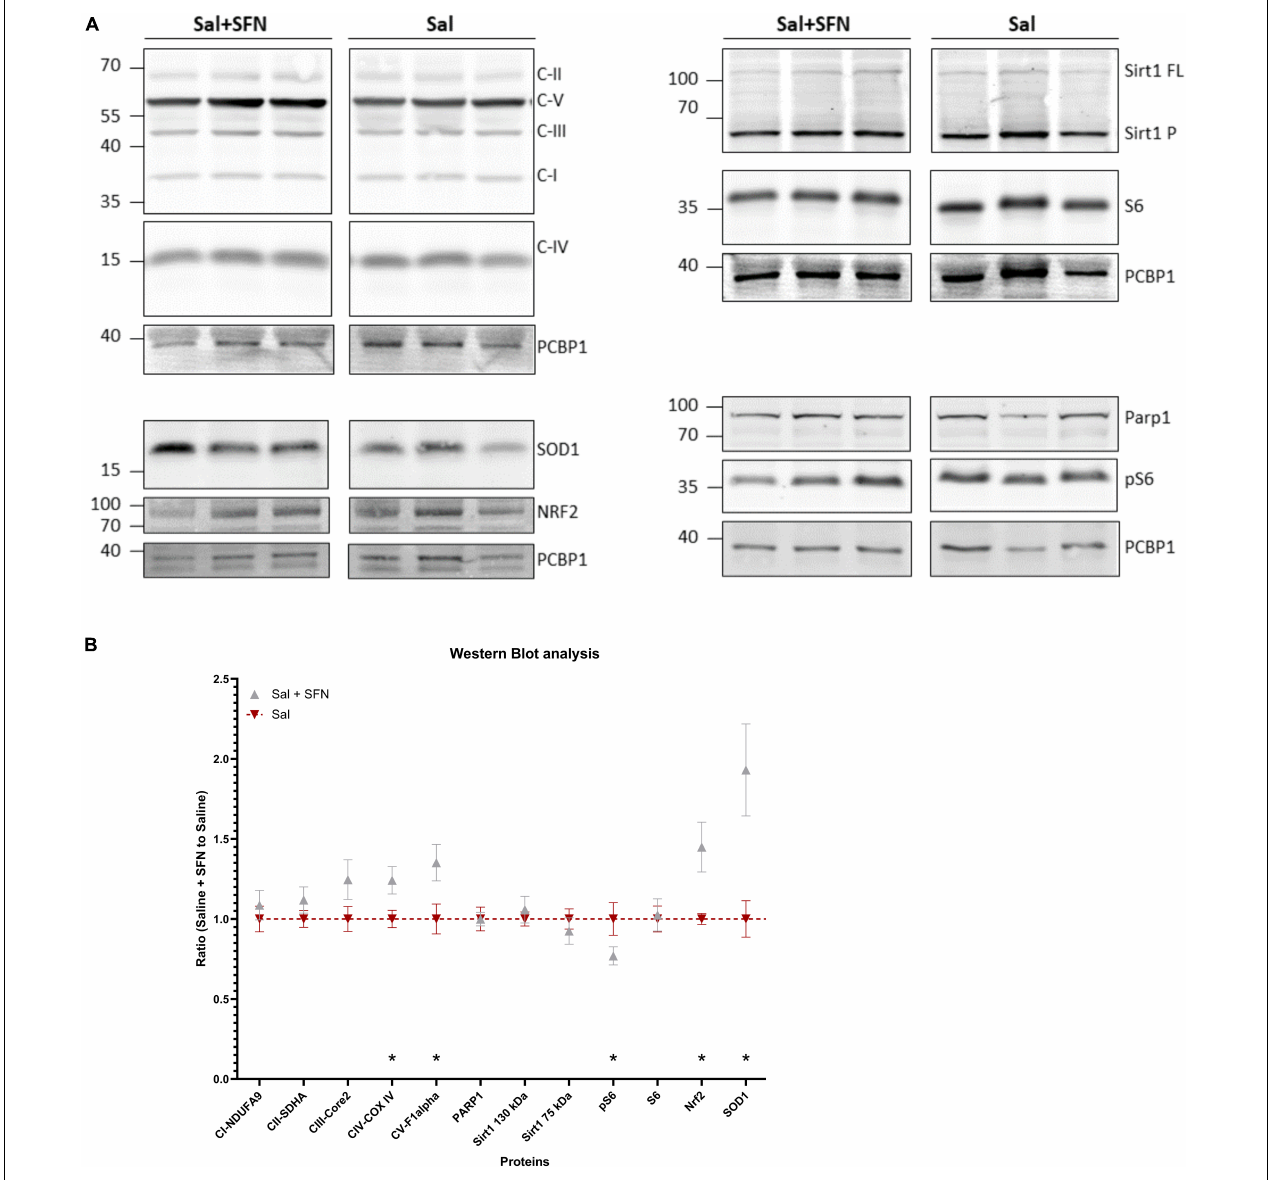
FIGURE 1 | Western blotting (WB) analysis normalized to the housekeeping protein (PCBP1). The data shown are from animals that differ only by sulforaphane (SFN) pretreatment, no status epilepticus (SE) was initiated. The SFN group was further normalized to the Control animals – the ratio of SFN-treated animals to Control animals is shown. (A) Representative gels from the same animals (Sirt1FL = Sirt1 130 kDa; Sirt1P = Sirt1 75 kDa). (B) WB signal quantification. We observe significantly increased expression of Nrf2 and its direct (SOD1) and indirect (CIV and CV) targets, along with pS6 decrease (two-way ANOVA with factors of Protein and SFN comparing Saline vs. Saline + SFN group: Interaction P < 0.05, Protein P < 0.05, SFN P < 0.001; Multiple uncorrected unpaired t -tests were run to compare expression differences between the groups at each protein. All values are reported as mean ± SEM (* P <